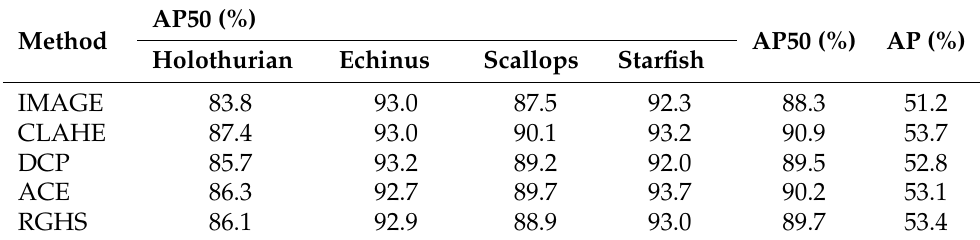
Table 1. Comparison of image processing algorithm experimental results.